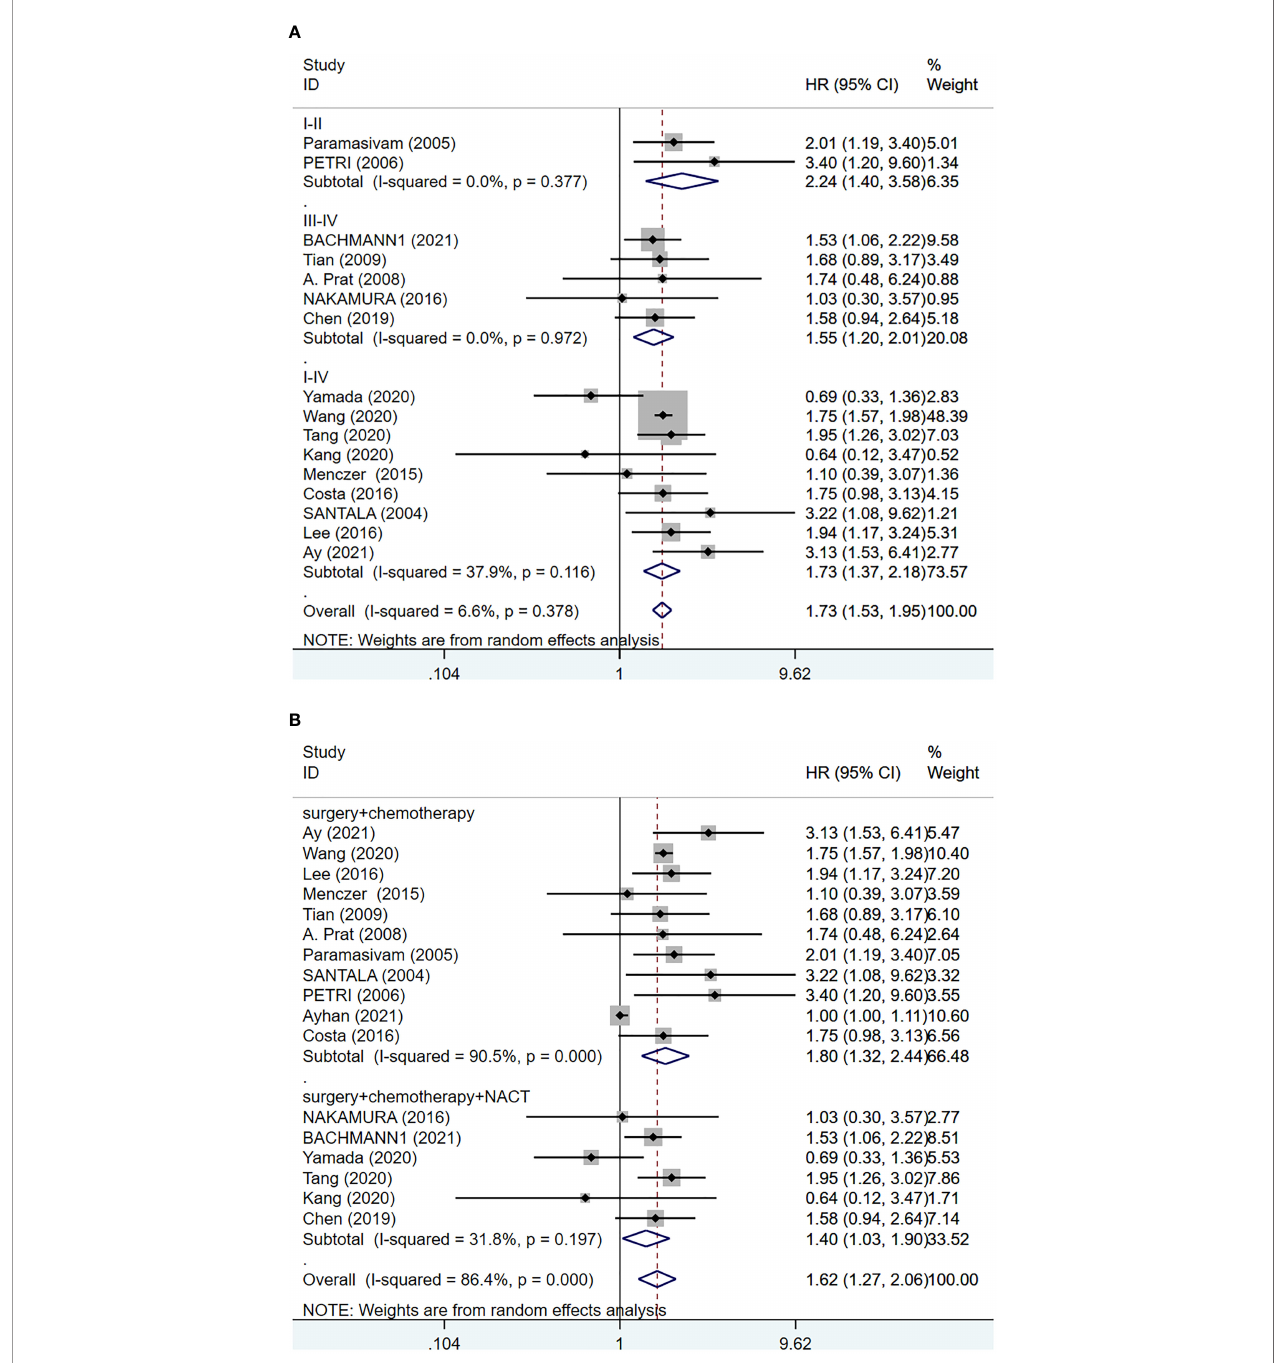
FIGURE 3 | Forest plot of the relationship between CA-125 level and clinical factors in EOC patients. (A) FIGO stage (I-II versus III-IV versus I-IV); (B) treatment (surgery + chemotherapy versus surgery + chemotherapy +